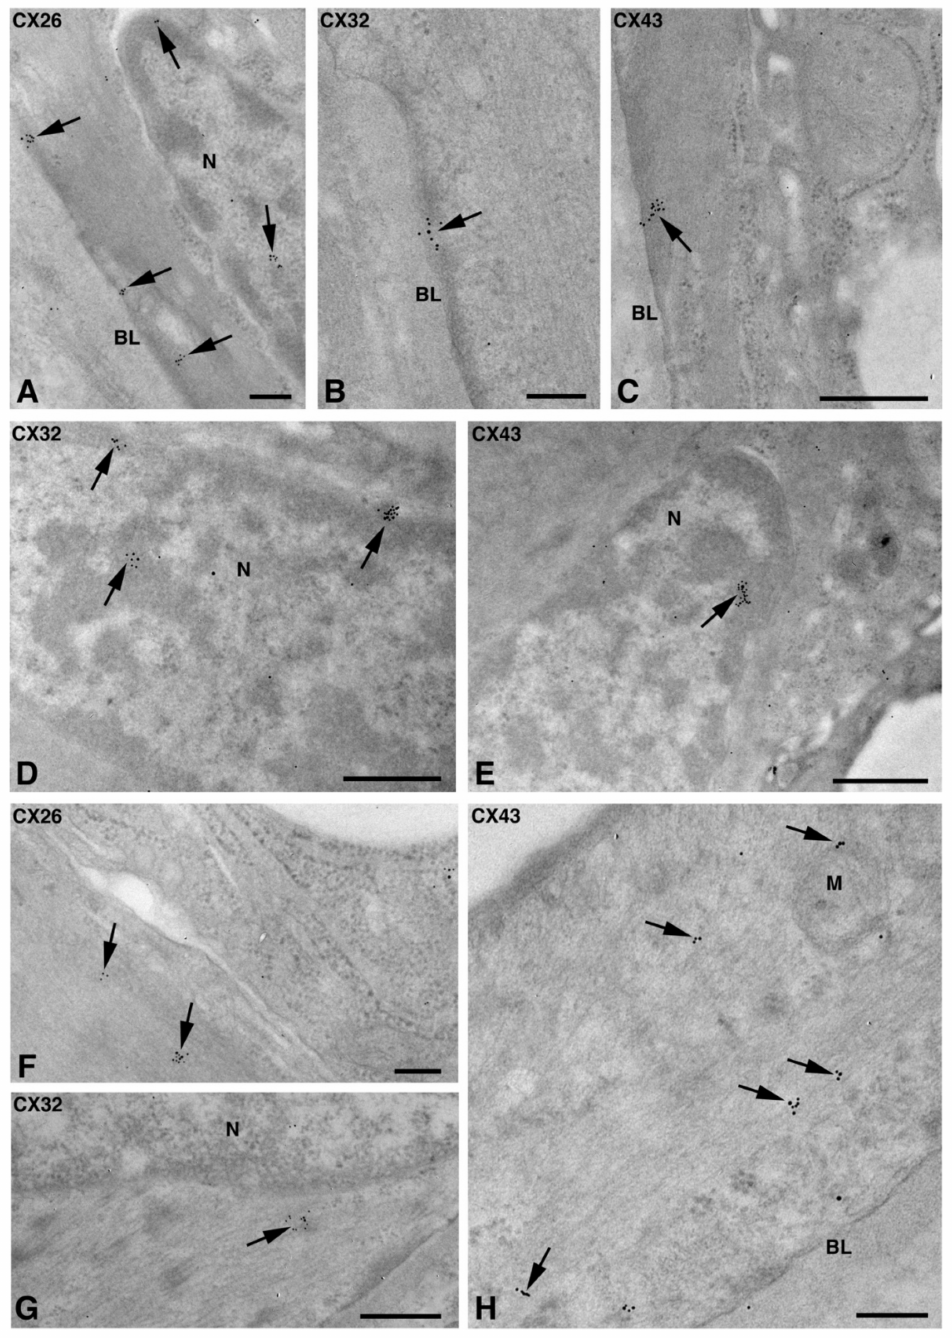
Figure 6. TEM immunogold analysis for Cx26 ( A , F ), Cx32 ( B , D , G ), and Cx43 ( C , E , H ) in NS-hLSGB myoepithelial cells. Immunoreactions (arrows) are visible at the level of the nucleus ( A , D , E ), the basal plasma membrane ( A – C ), among fibrils ( F – H ), and on the mitochondria ( H ). BL, basal lamina; M, mitochondrion; N, nucleus. Scale bars ( A , B , F , H ), 200 nm; ( C – E , G ) 500